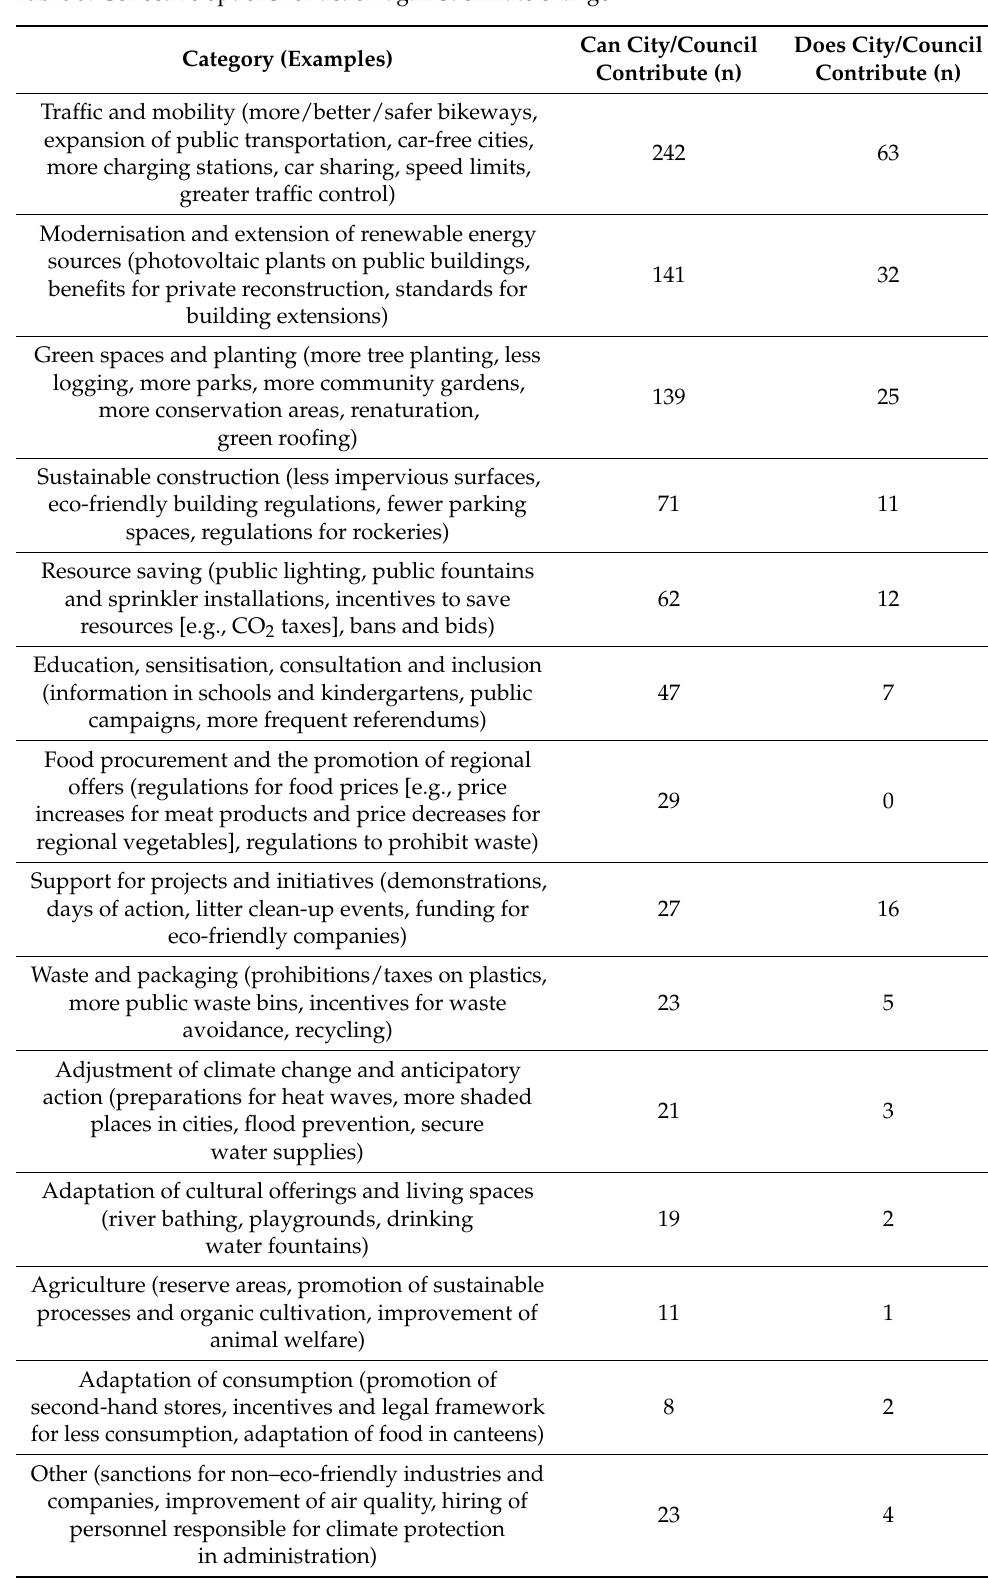
Table 5. Collective options for action against climate